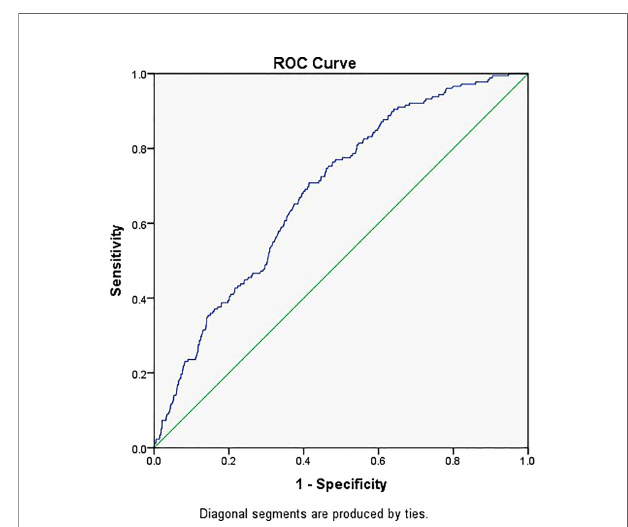
FIGURE 3 | Receiver operator characteristic curve of the embryo stage, BMI, tubal factor infertility, previous history of ectopic pregnancy, and EMT. Diagonal segments were produced by ties and the area under the curve was